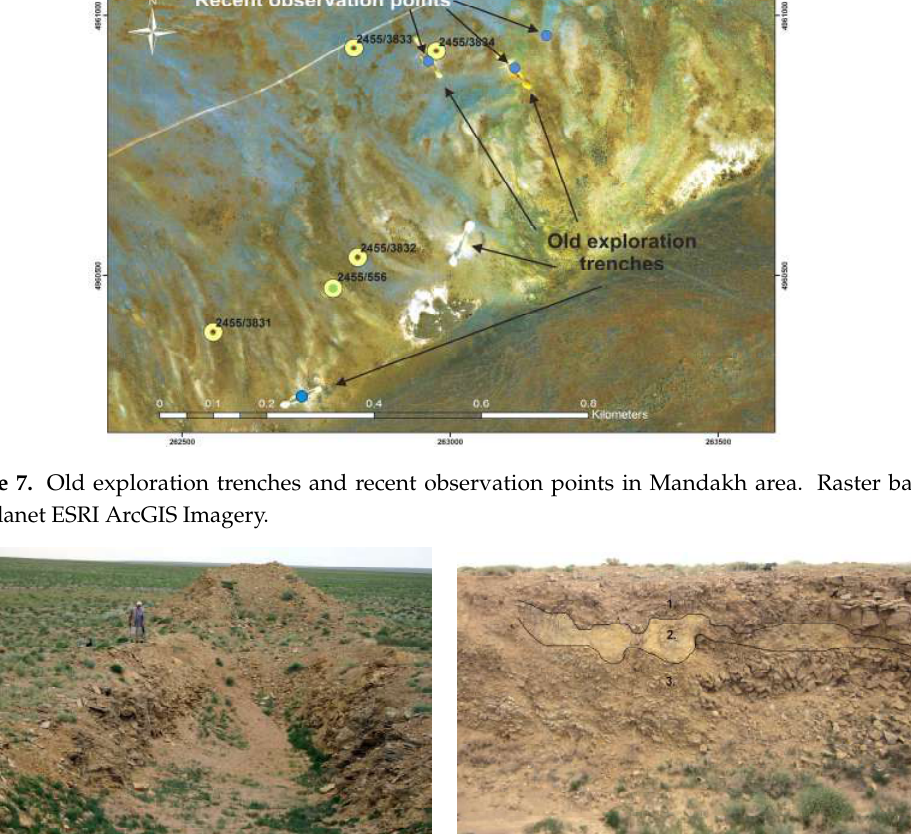
( d ) Figure 6. ( a ) WK183 light grayish-brown carbonaceous conglomerate with loose pebbles; ( b ) WK184 brownish-gray fine-grained sand, whitish-gray siltstone and dark to light gray siltstone; ( c ) WK161 brown sand with granite fragments clasts; yellow in the center is the reaction of nitric acid and ammonium molybdate with phosphorus in the sample; ( d ) WK157 coarse-grained granite, Late Triassic—Early Jurassic age.